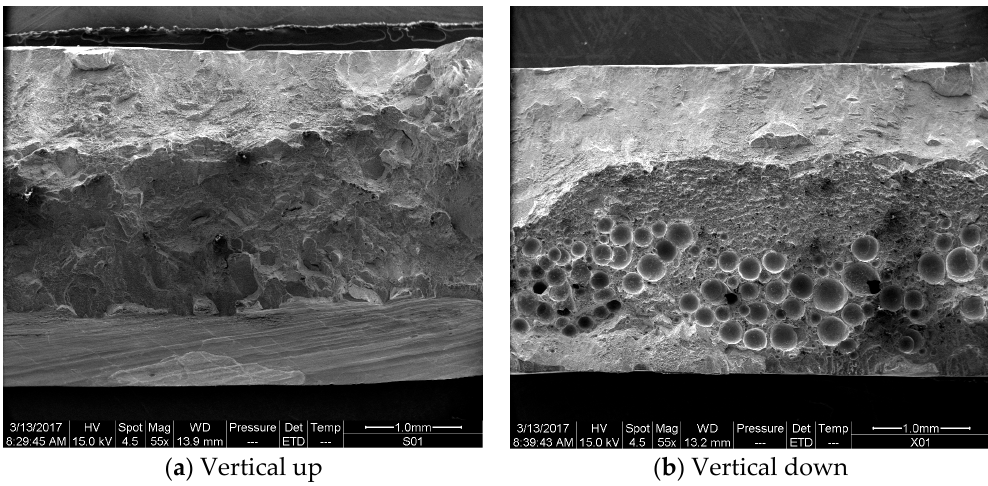
Figure 12. Fractographs of ( a ) vertical up weld and ( b ) vertical down weld with the higher heat input (2200 W, 0.5 m/min).